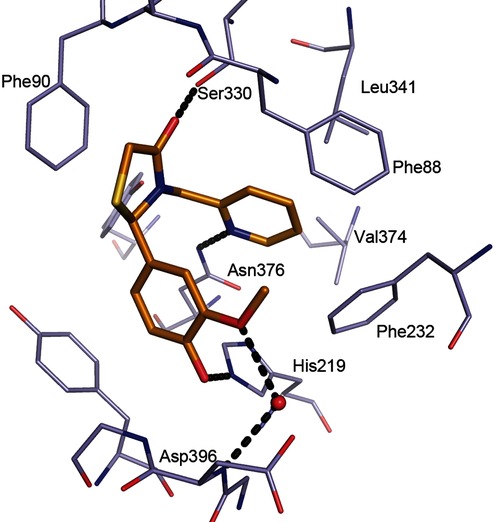
Binding of 13 to LmNMT. Hydrogen bonds are shown as dashed lines, and key residues are labelled.